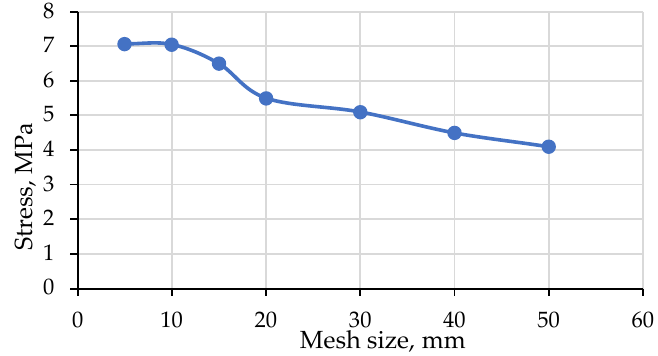
Figure 3. Mesh convergence study on hollow prism.